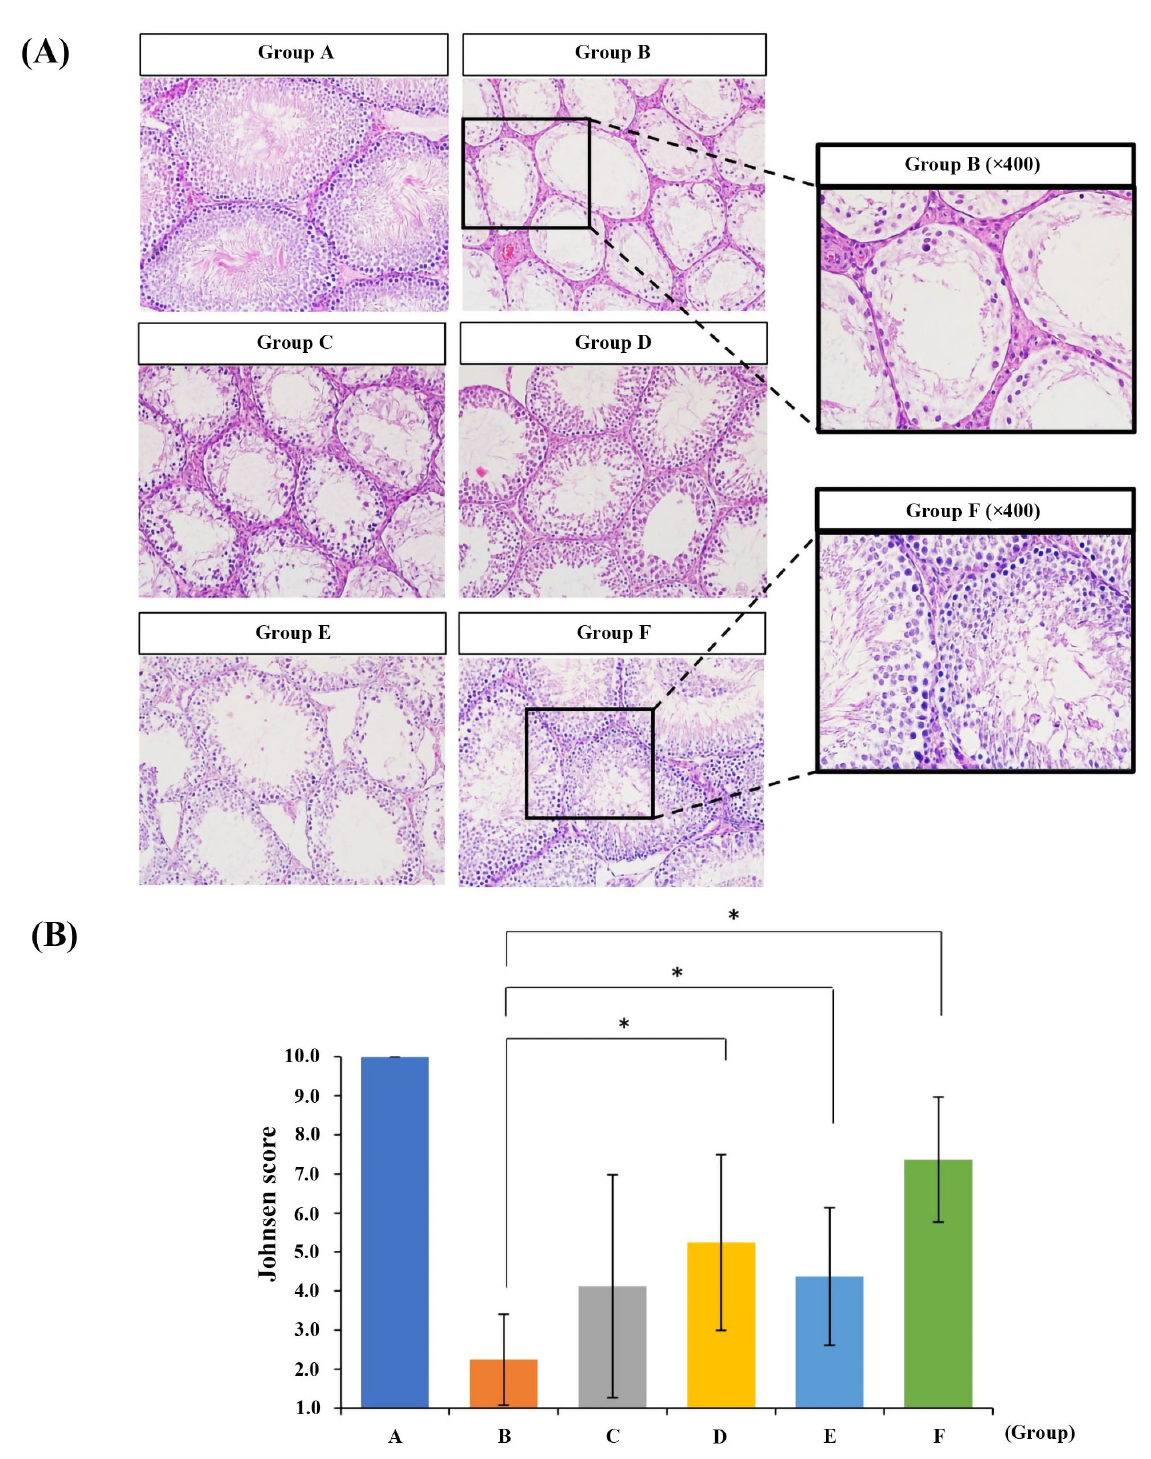
Fig. 3. Representative histopathologic images of the left testes (A) and the Johnsen scores (B) in groups A–F (n = 8 in each group). The magnification of the image is 200 × (the magnified image of group B and F is 400 × ). Group A: sham operation; Group B: torsion/detorsion (control group); Group C: torsion/detorsion with single administration of 0.3 mg/kg tadalafil; Group D: torsion/detorsion with daily administration of 0.3 mg/kg tadalafil for four weeks; Group E: torsion/detorsion with single administration of 1.0 mg/kg tadalafil: Group F: torsion/detorsion + daily administration of 0.3 mg/kg tadalafil for four weeks (* p <